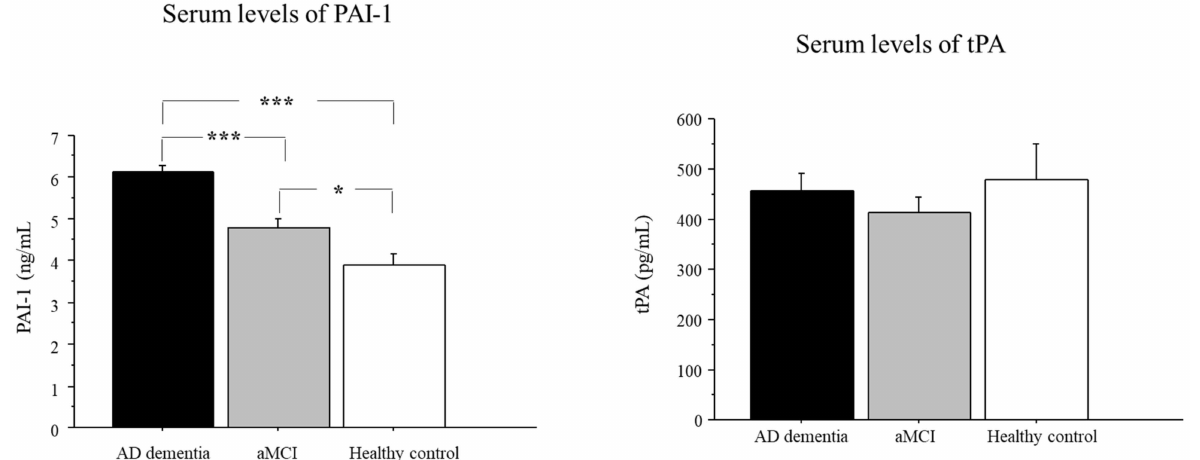
Figure 1. PAI-1 and tPA serum levels in AD dementia and aMCI patients and cognitively healthy controls. Data are the mean ± SEM. Values are expressed in ng/mL (PAI-1) and pg/mL (tPA). Asterisk (*) indicates a significant difference between the groups. * p < 0.05; *** p <